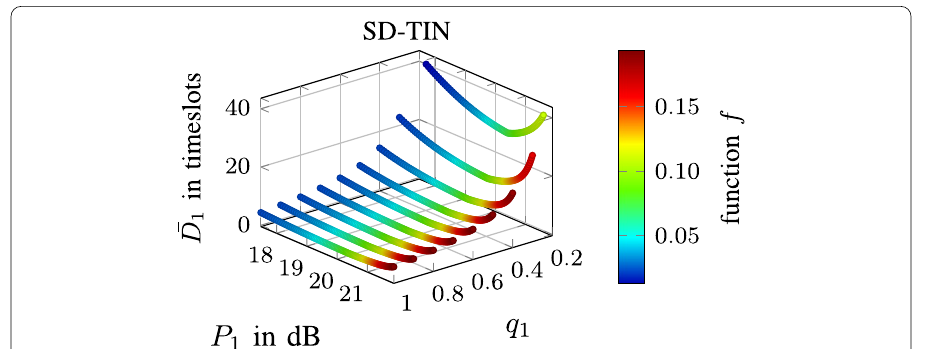
Fig. 4 ( ¯ D 1 , function f aw ) versus ( q 1 , P 1 ), under congestion-aware randomized policy in SD-TIN. The rest of the parameters are the following: (cid:31) 1 = 0.1 , γ 1 = − 4.2dB , γ 2 = − 6.4dB , α = 2.2 , β = 41dB , P J = 23dB , q 2 = 0.4 , B = 6 packets, P max = 23dB , d 2 = 14.6m , and d 12 = 10m . In SD-TIN, d 1 = 8.2m